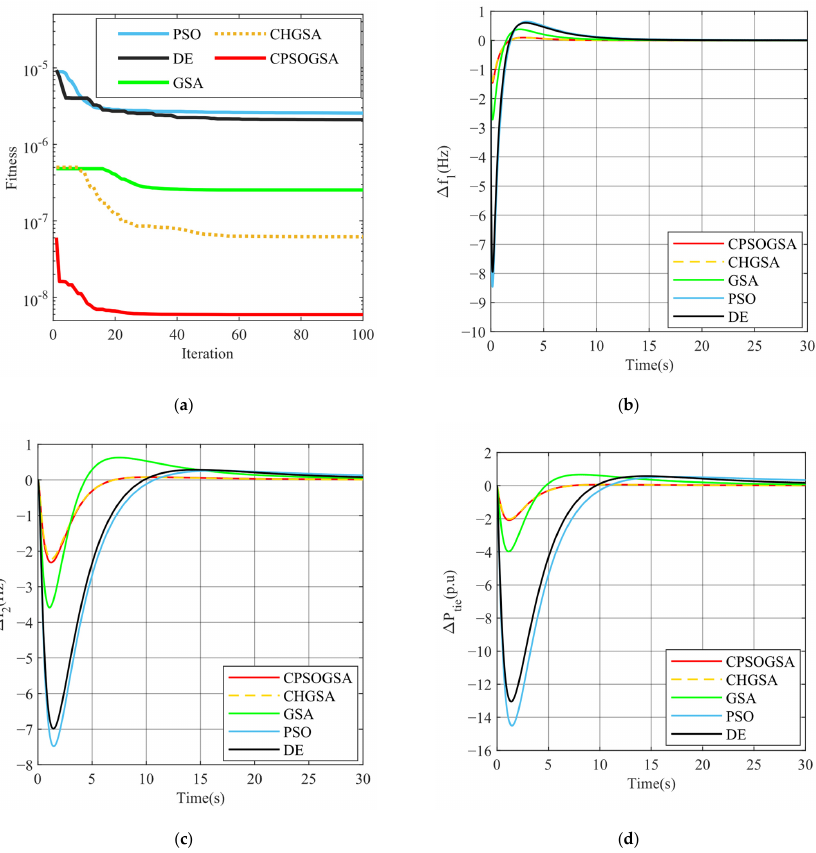
Figure 10. Algorithm iteration curve and dynamic system response ( a ) iterative process of different algorithms, ( b ) ∆ f 1 , ( c ) ∆ f 2 , and ( d ) ∆ P tie